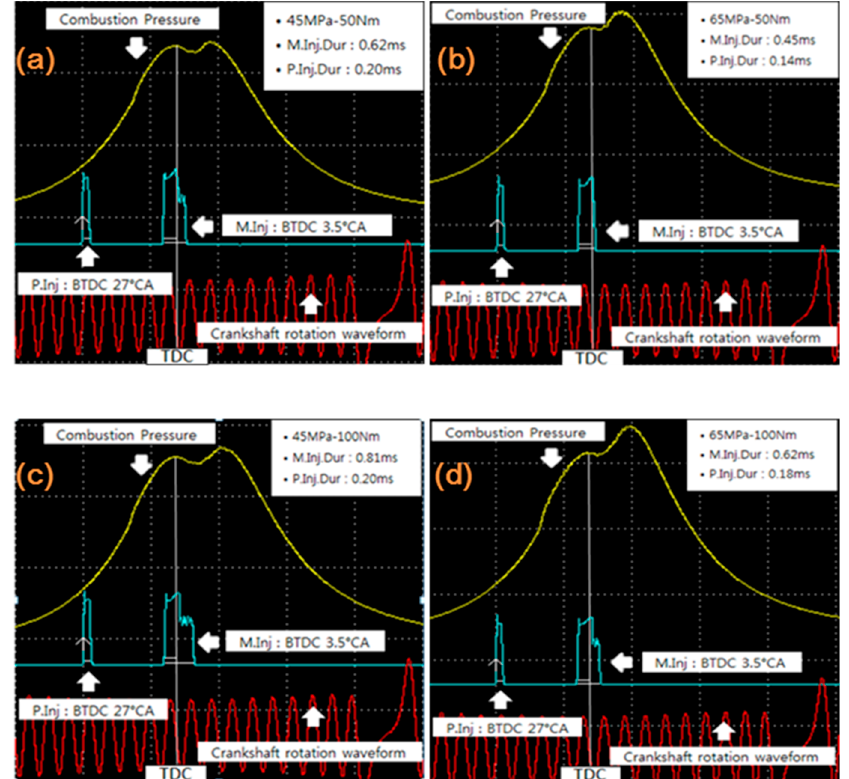
Figure 1. Curves of combustion characteristic of all tested fuels: ( a ) fuel injection pressure of 45 MPa and engine load of 50 Nm, ( b ) fuel injection pressure of 65 MPa and engine load of 50 Nm, ( c ) fuel injection pressure of 45 MPa and engine load of 100 Nm and ( d ) fuel injection pressure 65 MPa and engine load 100 Nm.